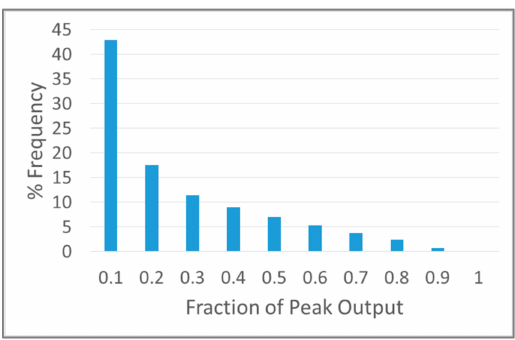
Figure 12. Percentage of daylight hours in each fraction of peak output bin